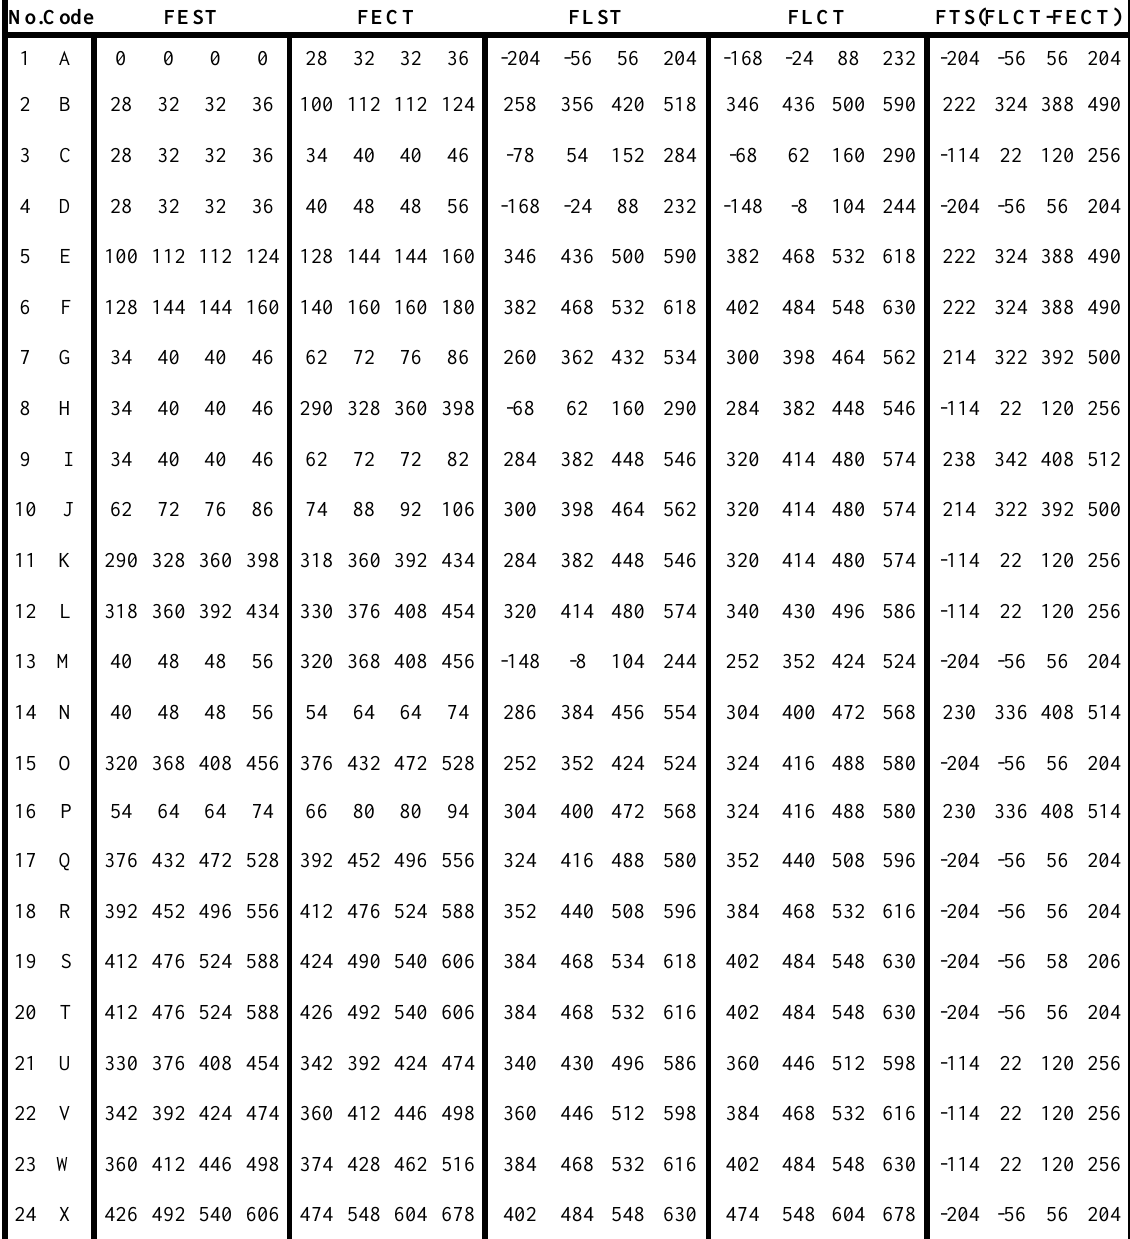
Table 3. Summarized fuzzy CPM parameters as follows shown as Figure